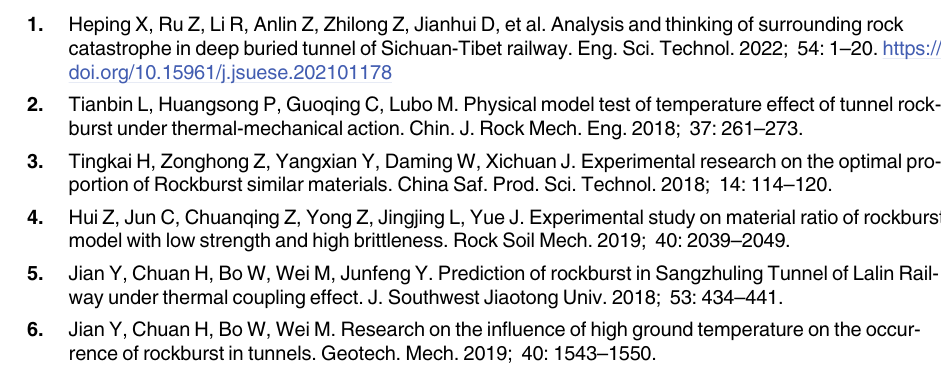
S10 Fig. Curve of peak compressive strength of compressive strength responses of similar materials at different temperatures. (OPJU) S11 Fig. Curve of peak compressive strength of raw rock at different temperatures. (OPJU) S12 Fig. Peak displacement curve of compressive strength responses of rockburst-like materials at different temperatures. (OPJU) S13 Fig. Peak displacement curve of raw rock at different temperatures. (OPJU) S14 Fig. Elastic modulus curve of elastic moduli responses of rockburst-like materials at different temperatures. (OPJU) S15 Fig. Elastic modulus curve of raw rock at different temperatures.